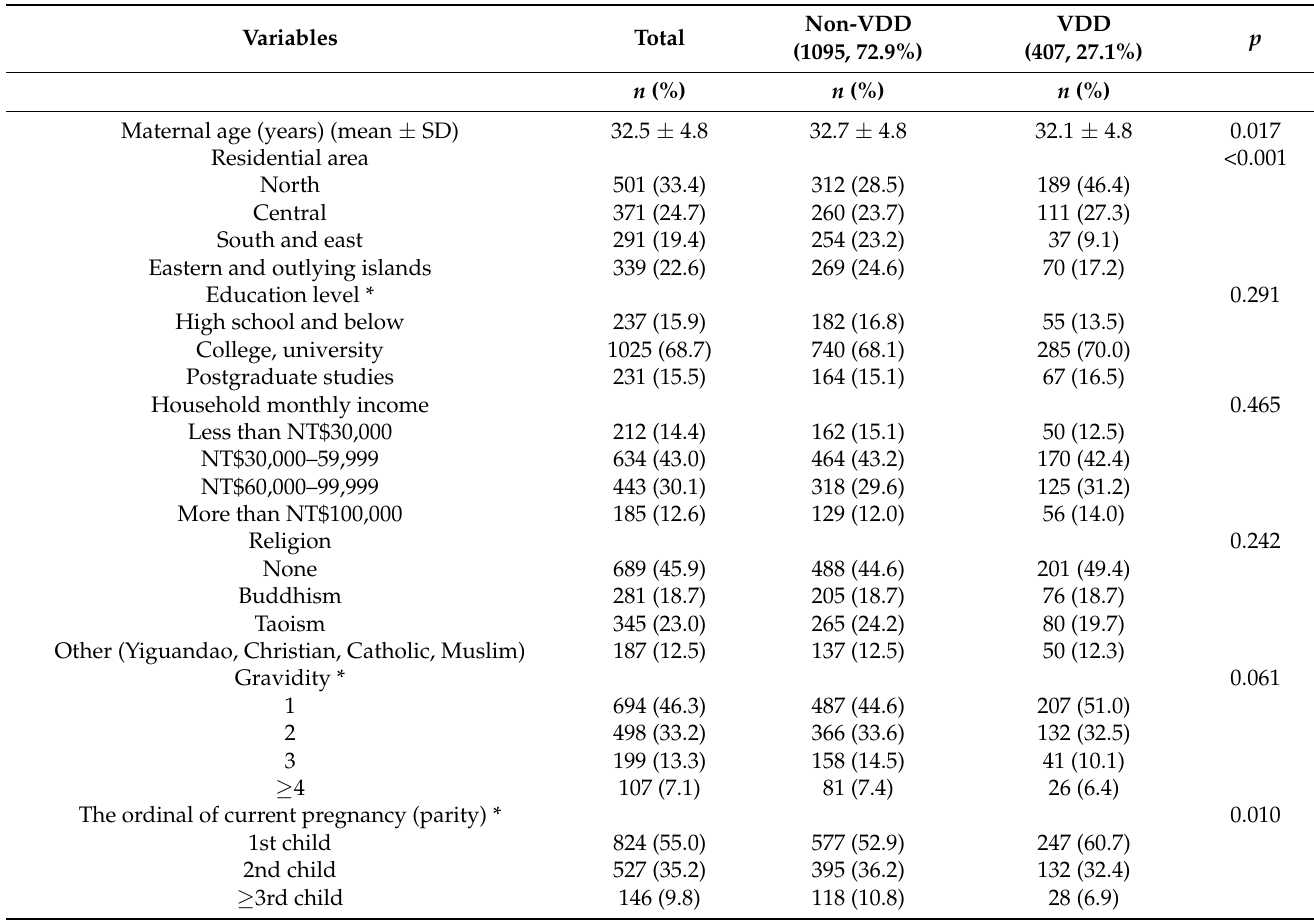
Table 1. Characteristics of study participants according to vitamin D status ( n =